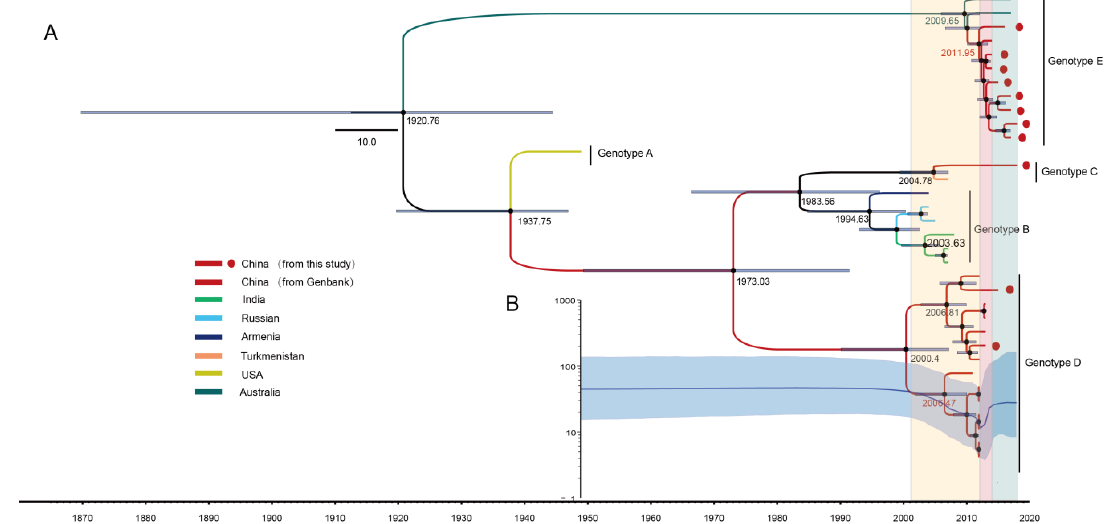
Figure 2. ( A ) The maximum clade credibility (MCC) phylogenetic tree generated using the Markov chain Monte Carlo (MCMC) method based on the complete VP1 sequences of 34 CV-A8 variants and coloured according to different countries. The scale bar represents time in years. The tree was node-labelled with inferred dates of lineage splits. Each genotype is noted on the right. ( B ) Bayesian skyline plot of the 34 CV-A8 VP1 region sequences, reflecting the relative genetic diversity from 1949 to 2018. The x -axis is the time scale (years), and the y -axis is the effective population size. The solid line indicates the median estimates, and blue shading indicates the 95% highest posterior density. The three stages of effective population size are shaded with light yellow, rose and aqua.